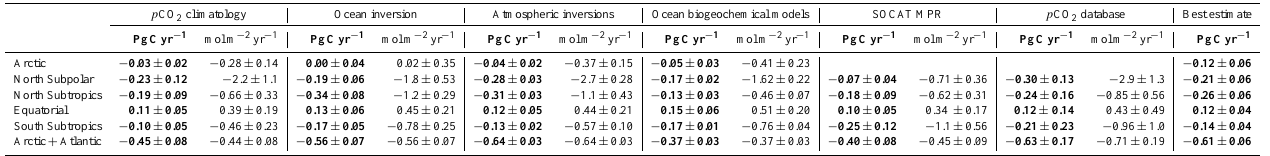
Fig. 3. The 1990–2009 long-term mean sea–air CO 2 flux [PgCyr − 1 ] in the (a) Arctic, (b) North Subpolar, (c) North Subtropics, (d) Equatorial, and (e) South Subtropics for Tier 1 methodologies: p CO 2 climatology, median of ocean inversion, median of atmospheric inversions, median of ocean models, and additionally IAV for SOCAT MPR and p CO 2 database. Rivers fluxes of Jacobson et al. (2007) have been added to the ocean model estimates as required (described in text). Uncertainty is the median absolute deviation for the atmospheric inversions and ocean models, 50% of the mean for the p CO 2 climatology and SOCAT MPR, the mean annual uncertainty for the p CO 2 database trend, and the published uncertainty for the ocean inversion (Gruber et al., 2009). Table 4. 1990 to 2009 mean flux in each region and whole Arctic/Atlantic for Tier 1 methodologies (climatology, ocean inversion, atmo- spheric inversion, and ocean biogeochemical models), and observations (SOCAT MPR and p CO 2 database). Pixel areas for each region are given in the last column of Table 3). Atmospheric inversions begin in 1995. The best estimate for each region except the Arctic is the mean of the p CO 2 climatology and ocean inversion, with uncertainty from standard error propagation. The Arctic’s best estimate is derived from other studies, as explained in the text. Uncertainty of the best estimate for the whole Arctic + Atlantic is calculated with standard error